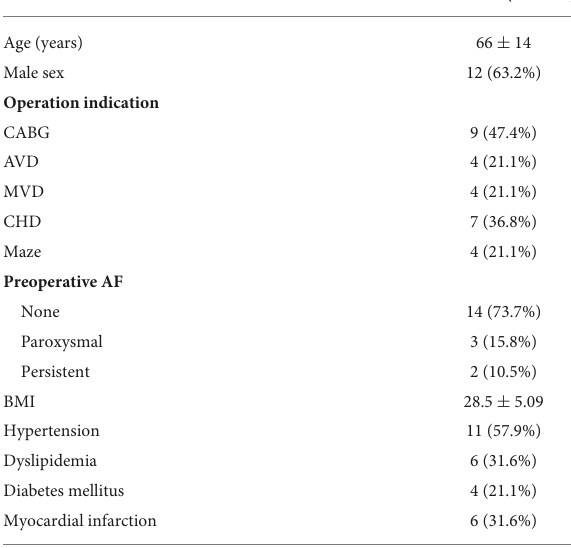
TABLE 1 Patient